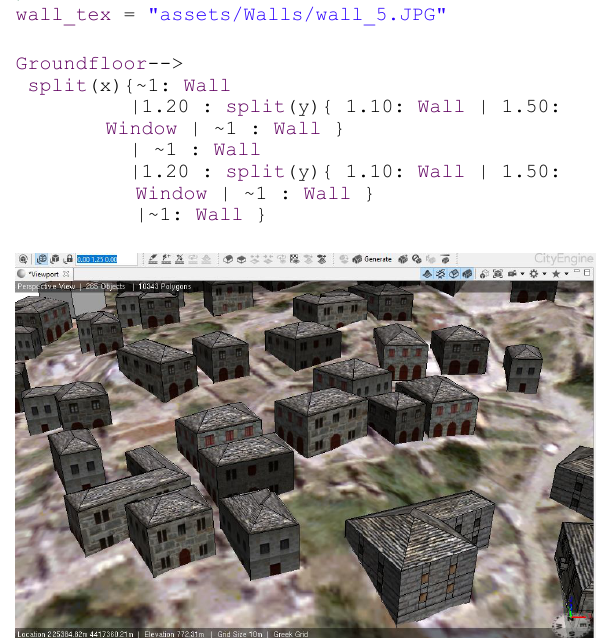
Figure 7. Lod2 models in CityEngine Viewport